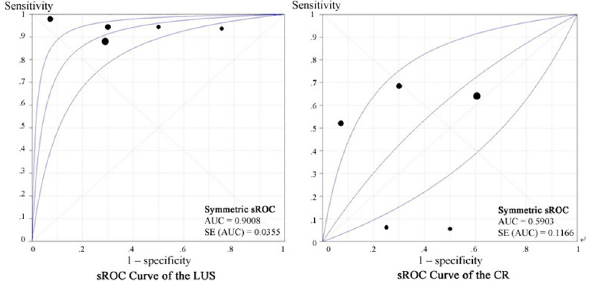
Fig 4. The summary receiver operating characteristic of lung ultrasonography and chest radiography for the detection of pneumonia compared with computed tomography scan. AUC: areas under the curve; CR: chest radiography; LUS: lung ultrasonography; sROC: summary receiver operating characteristic.